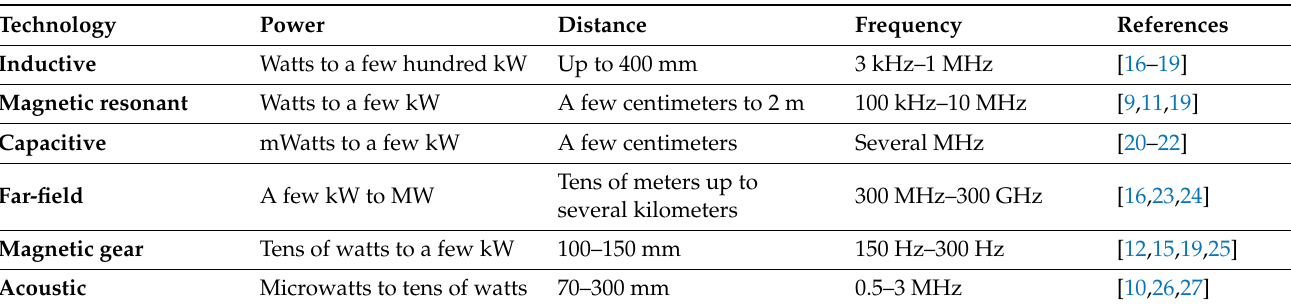
Table 1. Comparison of various WPT